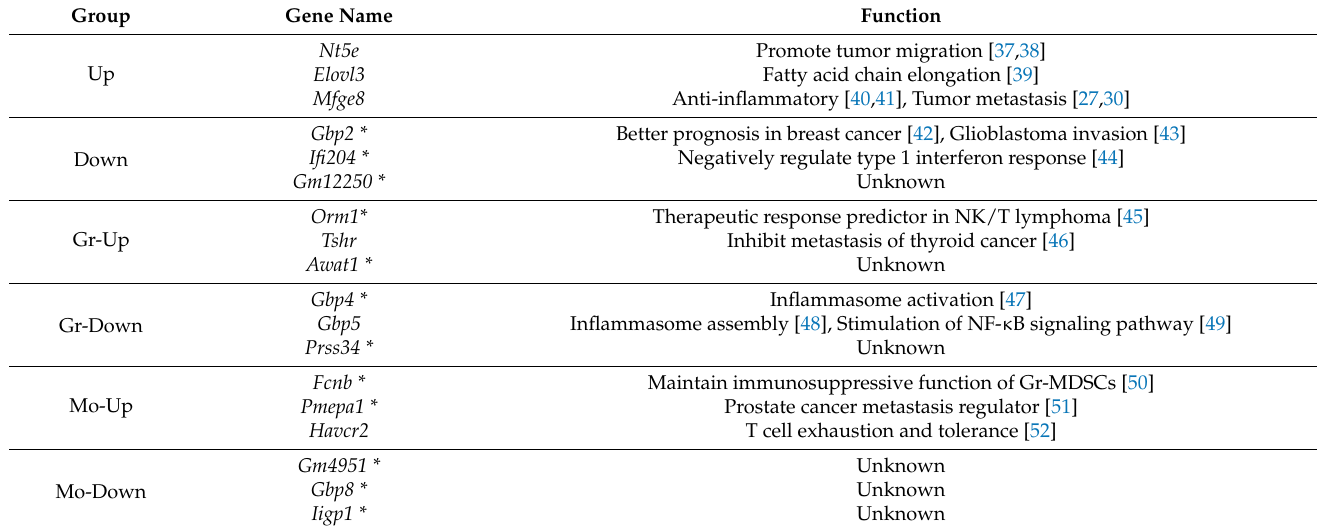
Table 1. Known functions of the 18 genes selected from the microarray data. The top three genes in each of the six groups were selected for further analysis. The function of some genes has not been well-studied, and these genes are denoted as ‘unknown’.